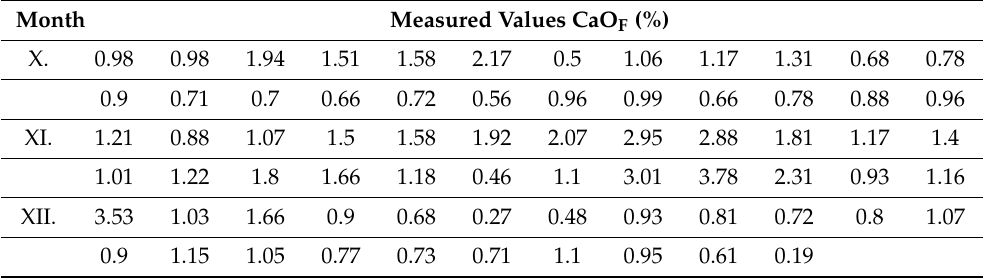
Table 2. Measured values—free lime content in clinker (CaO F )—(%). Month Measured Values CaO F (%)